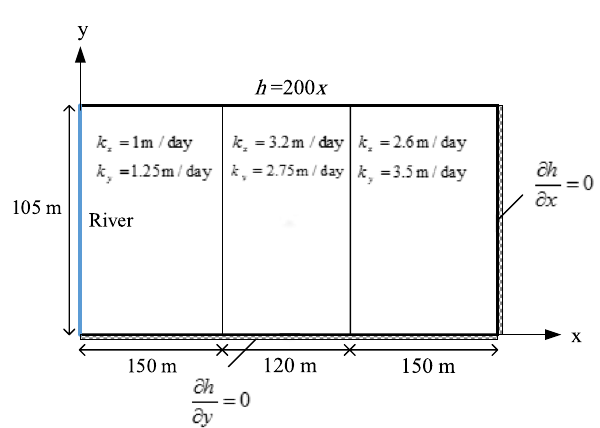
Fig. 14 Contours of hydraulic head (m) for the third problem with 25 nodes